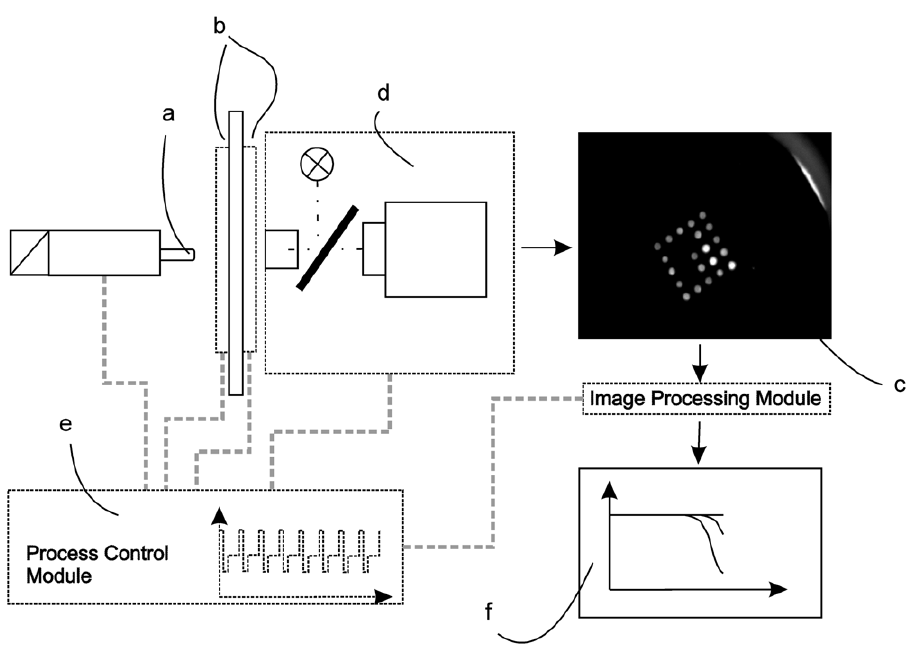
Figure 7. Principal scheme of the test device. The mechanical module contains a plunger ( a ) that is used to reversibly squeeze and release the reaction chamber. The temperature control module comprises two peltier elements with an aperture in the center ( b ). Fluorescence images of the array ( c ) are acquired by the optical detection module ( d ). Synchronized simultaneous performance of all components is controlled by the process control module ( e ), which also controls the thermal regime of the amplification reaction. After image acquisition, the hybridization pattern is analyzed by the image analysis module. Results are visualized as a plot of intensity on each individual probe versus the respective cycle number ( f ). doi:10.1371/journal.pone.0035438.g007 many). HIV2- RNA was isolated from HIV-2 subtype A strain ROD from cell free culture supernatant obtained from the National Institute for biological Standards & Control (NIBSC),